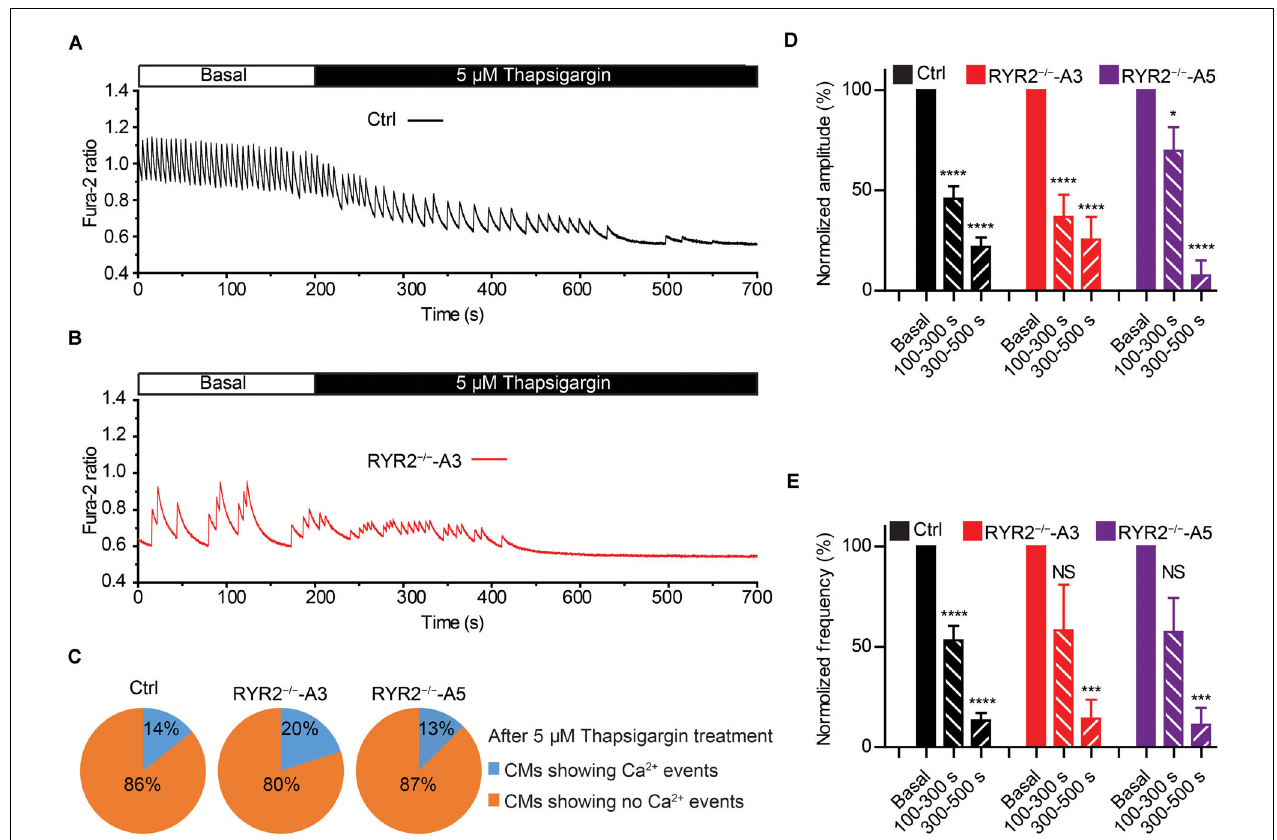
FIGURE 8 | Contributions of SERCA-mediated SR Ca 2 + uptake to spontaneous Ca 2 + transients in Ctrl- and RYR2 − / − -iPSC-CMs. (A,B) Representative cytosolic Ca 2 + dynamics in Ctrl- (A) and RYR2 − / − -iPSC-CMs (B) before and after the addition of SERCA inhibitor thapsigargin (5 µ M). (C) Pie charts depict the percentage of cells maintaining Ca 2 + transients after the treatment with thapsigargin for 500 s. (D,E) Changes of Ca 2 + transient amplitude (D) and frequency (E) after the treatment with thapsigargin, which were normalized to those from the same cell under the basal condition. (Ctrl: n = 14 cells from three differentiation experiments; A3 RYR2 − / − : n = 10 cells from three differentiation experiments; A5 RYR2 − / − : n = 8 cells from two differentiation experiments). * P < 0.05; *** P < 0.001; **** P < 0.0001 by using the one-way ANOVA with the Dunnett’s multiple comparison